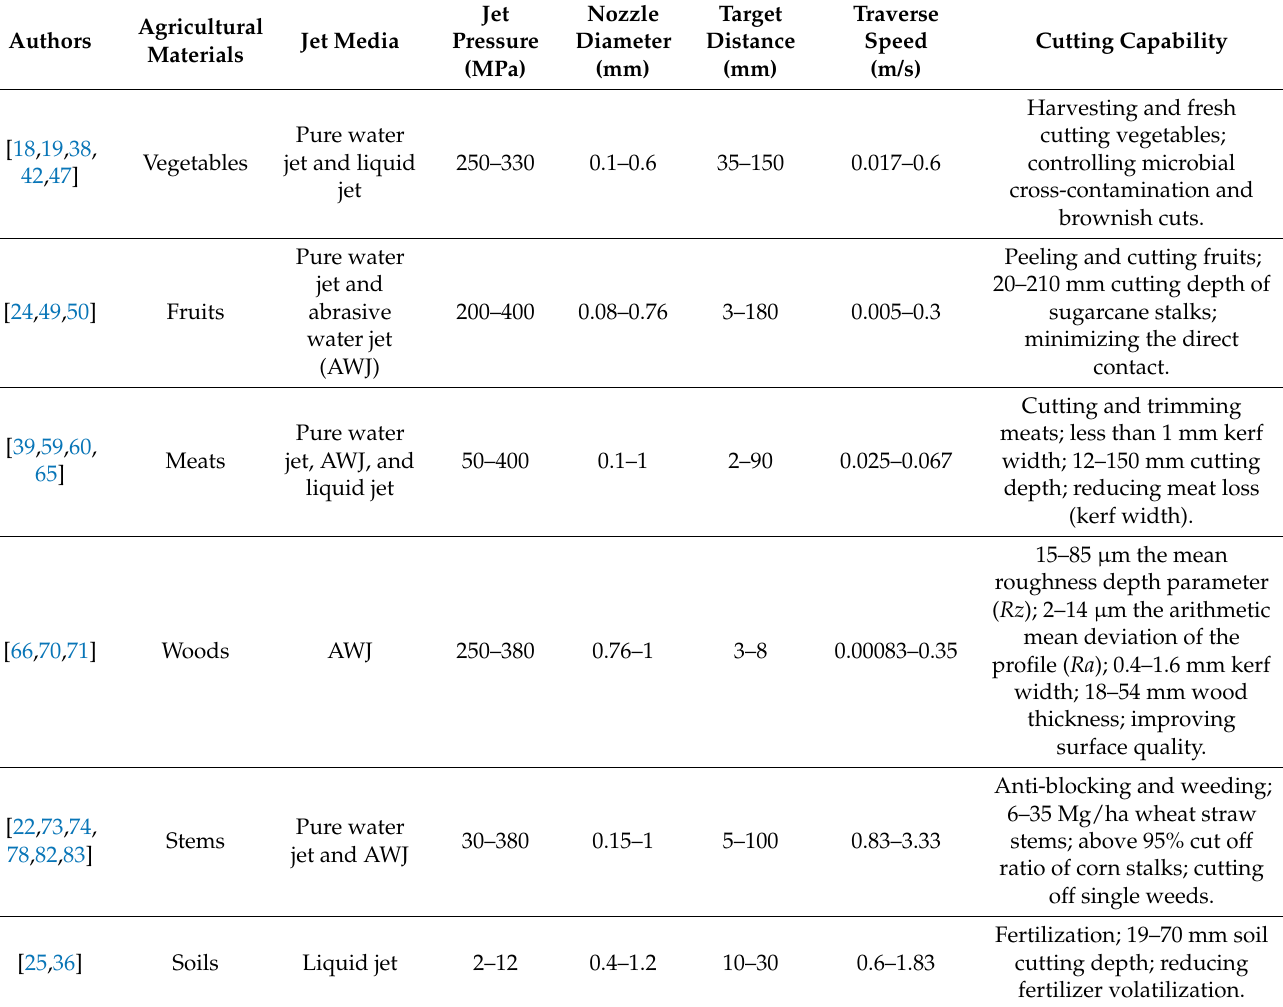
Table 2. Cutting six kinds of agricultural materials under different jet media and typical